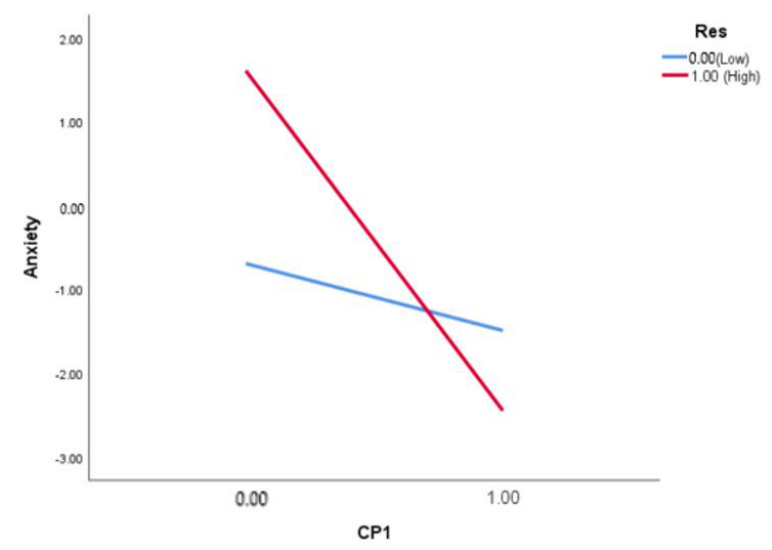
Figure 3. Moderating effect of resilience on the relationship between a planful coping skill (CP1) and